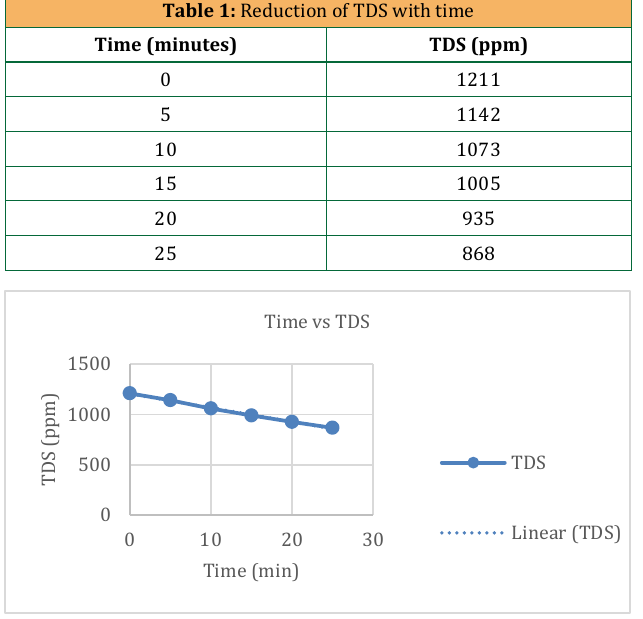
Figure 2: Graph between time and TDS